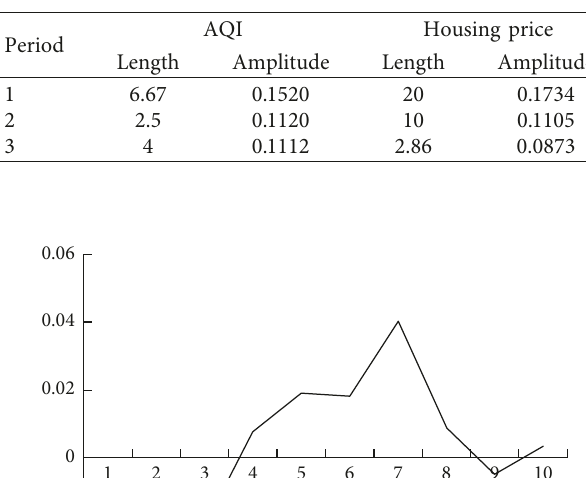
Figure 5: Spectrum of AQI and housing price power in Handan. Table 2: Main period and amplitude of AQI and housing price in Handan.